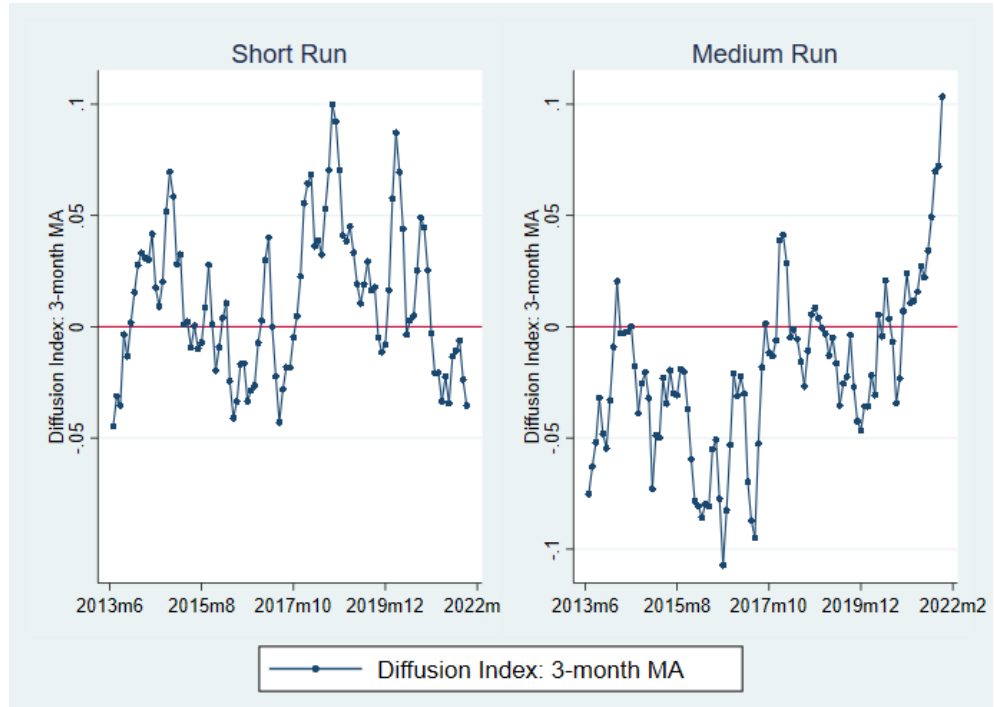
Figure 4. The figure shows the diffusion indexes of the assessed risk weighting around short run and medium run projections. It is calculated by, for each month, subtracting the survey-weighted share of participants whose distributions are negatively skewed from the share of participants with positively skewed